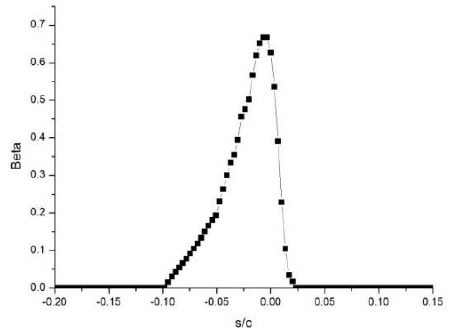
Figure 3. Distribution of droplet collection coefficient.